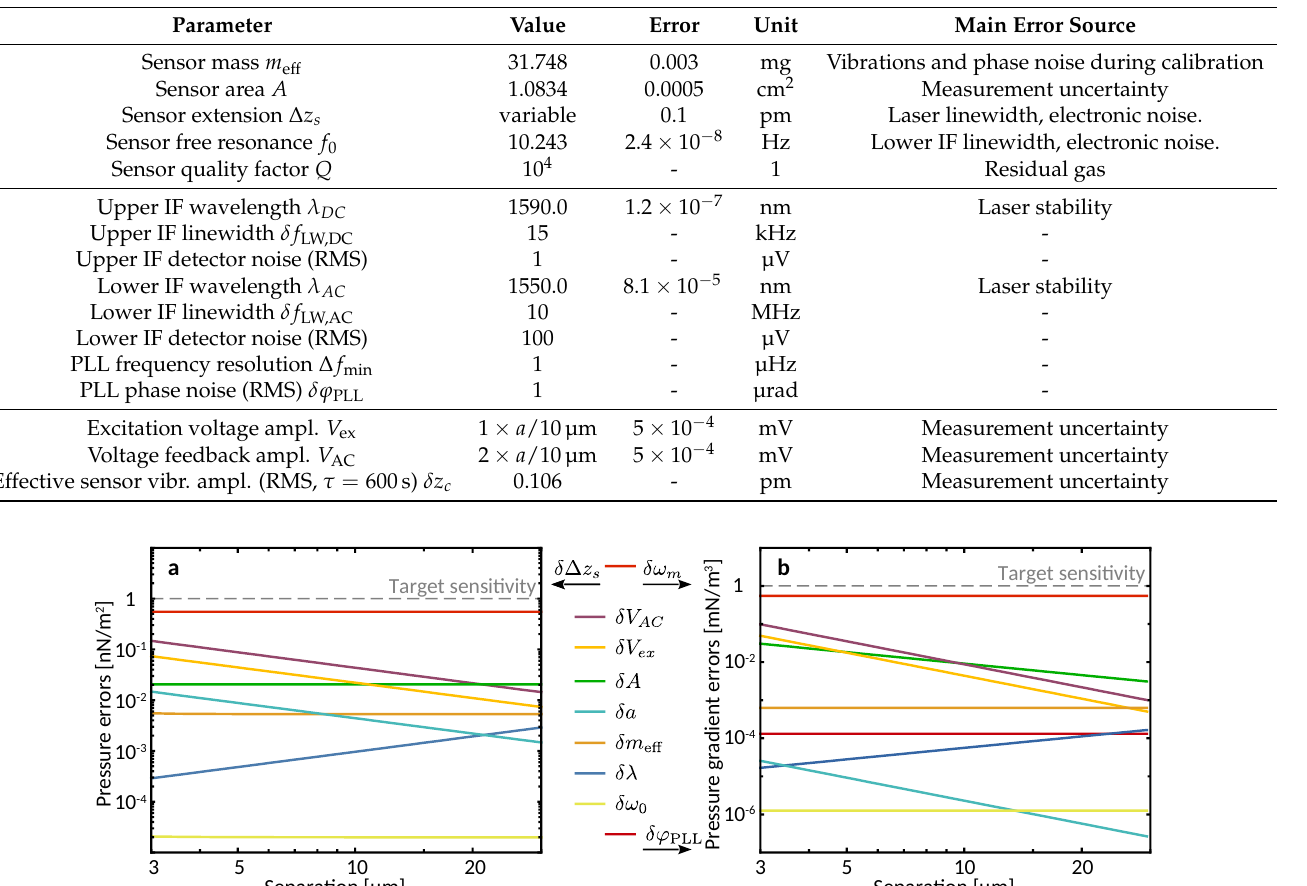
Table 2. Parameters and their uncertainties/errors used for the analysis of the detection error δ M det (IF = Interferometer).